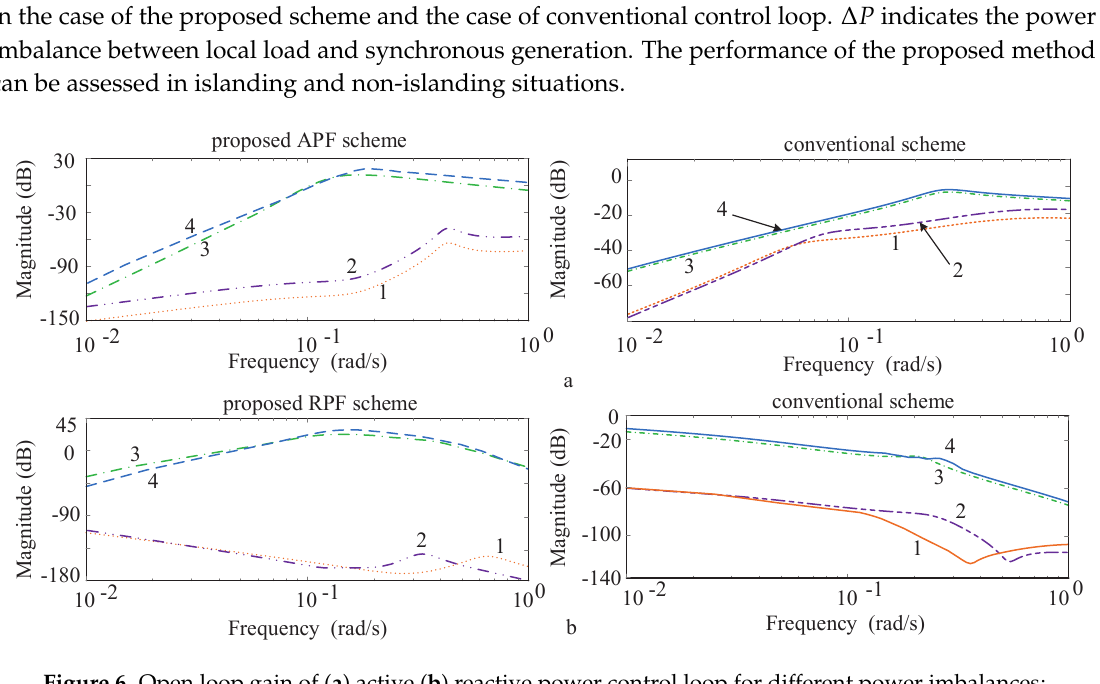
Figure 6. Open loop gain of ( a ) active ( b ) reactive power control loop for different power imbalances; 1 Grid-connected ∆ P = 0.5%, 2 Grid-connected ∆ P = 2.0%, 3 Islanding ∆ P = 0.5%, 4 Islanding ∆ P =